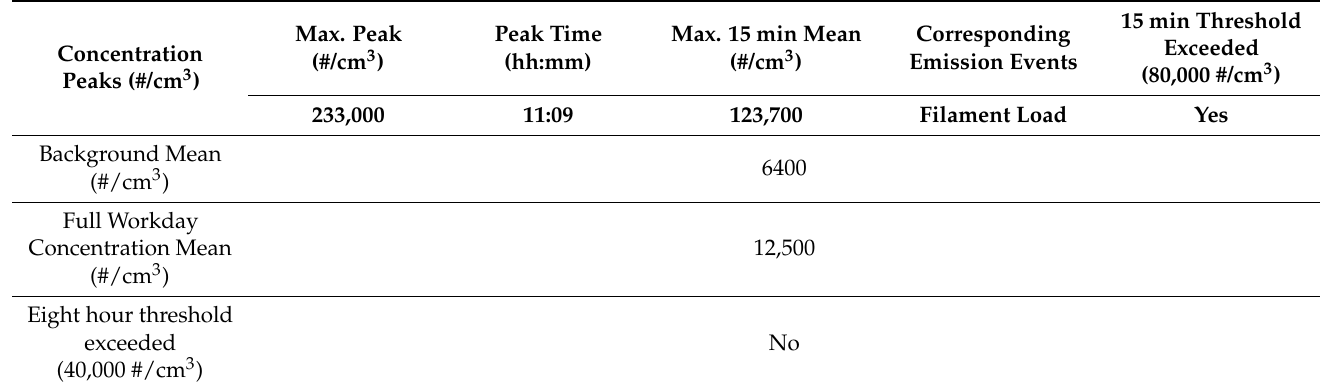
Figure 2. Particle Concentrations for Case 1. Table 2. Measurement Overview for Case 1—Comparison with exposure thresholds.